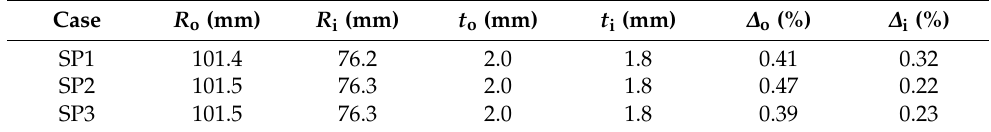
Table 1. Geometrical parameters of cases performed by An et al. [6] in experiments.